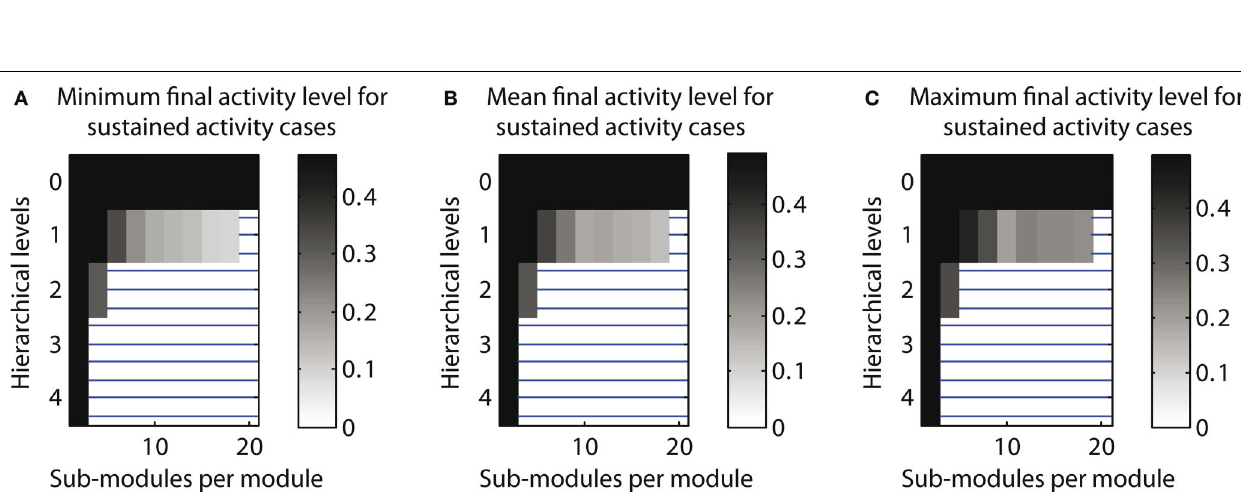
= m = const.; see main text). (C) Increasing number of sub- i